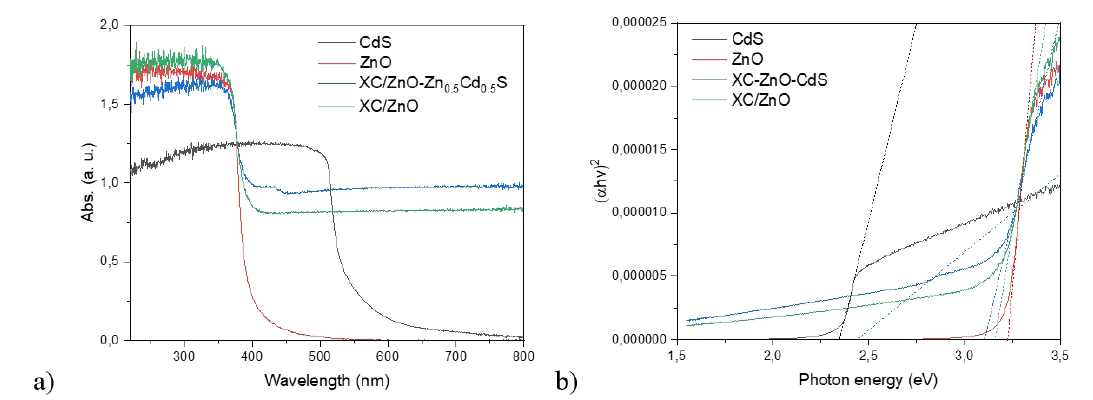
Cd S; b) Tauc plot for the ZnO, CdS, and XC/ZnO-Zn 0.5 0.5